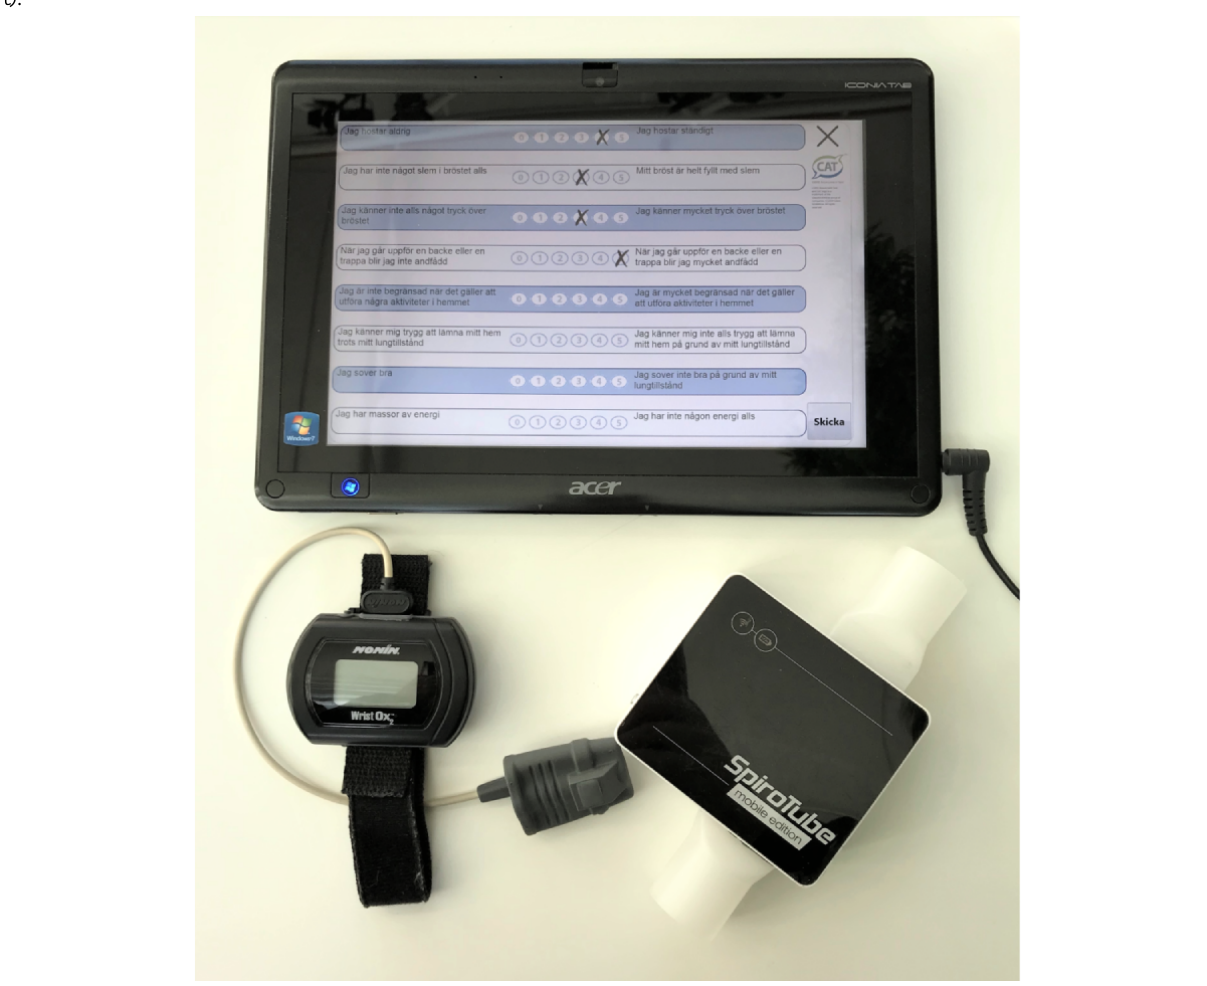
Figure 1. The telemonitoring system: a tablet computer with the telemonitoring system (top), a pulse oximeter (bottom left), and a spirometer (bottom